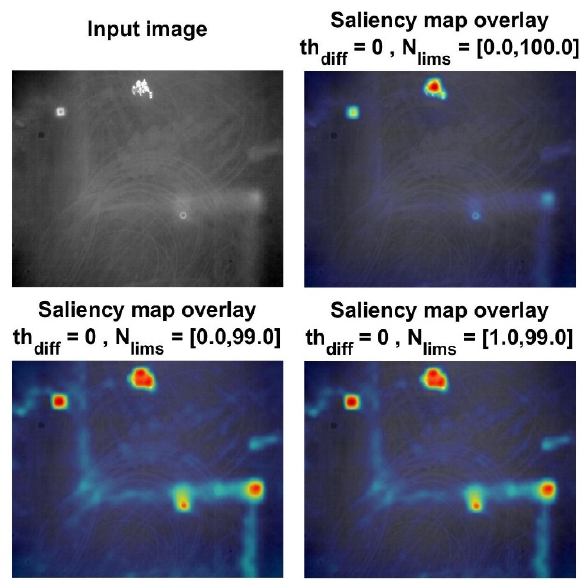
Figure 3: Effect of the normalization limits on the saliency com- putation (for the meaning of colour, see caption of Figure 2).